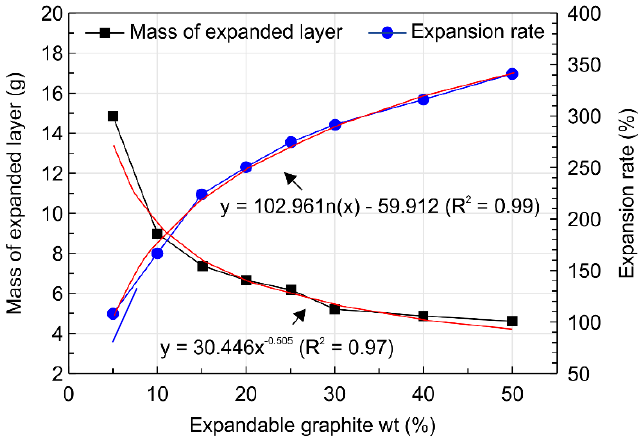
Figure 8. Variations in the expansion rate and mass of expanded layer with expandable graphite content.